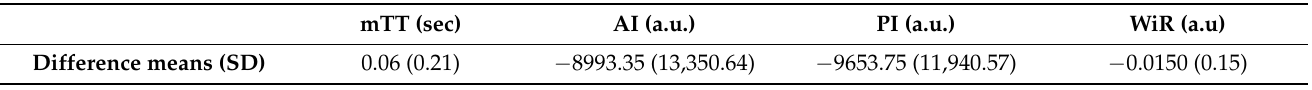
Table 2. Perfusion variables mean of the difference between scan1 and scan2; n = 10.